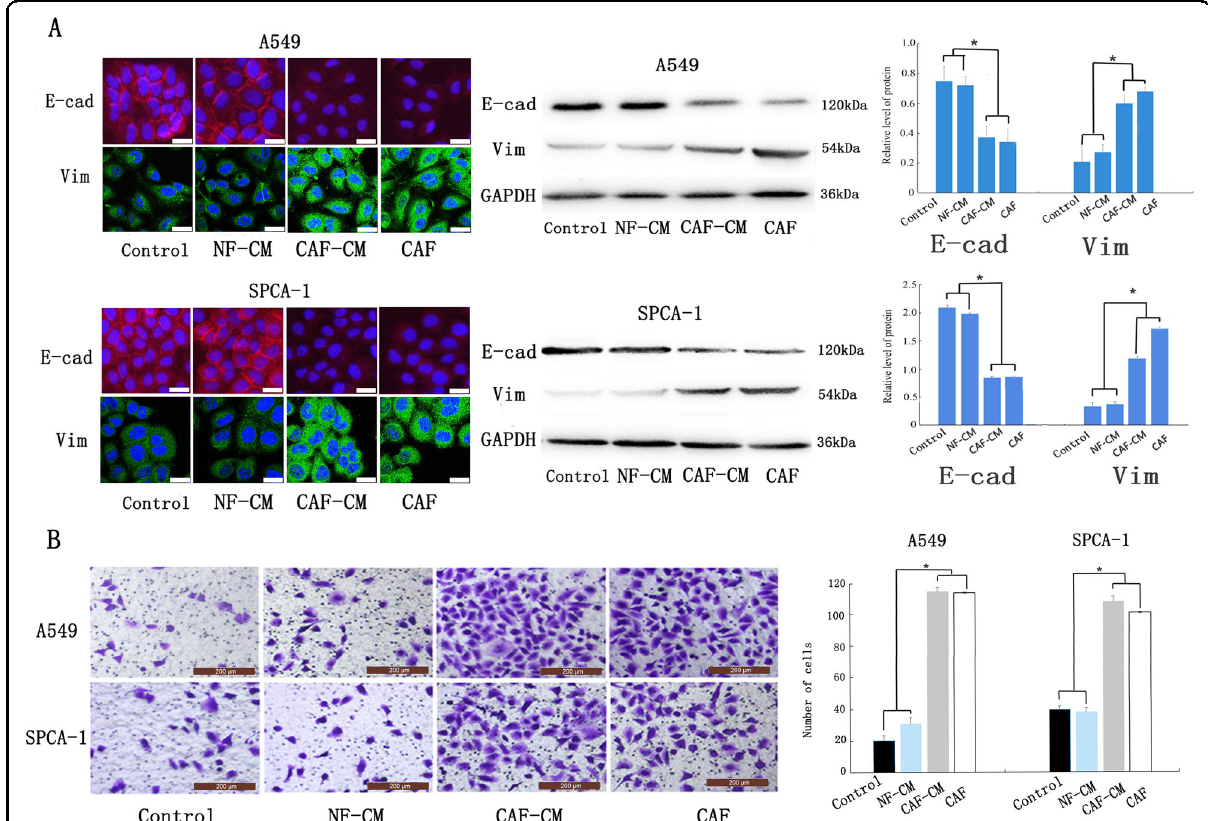
Fig. 2 CAF-CM induces EMT in lung ADC cells. a Expression of epithelial marker E-cadherin and mesenchymal marker vimentin via western blotting analysis and immuno fl uorescent staining; scale bar: 25 μ m. b Transwell assay examining the invasiveness of cells; scale bar: 200 μ m. Data are representative images and numerical data are represented as the mean ± SD of each group of cells from three separate experiments. * p <